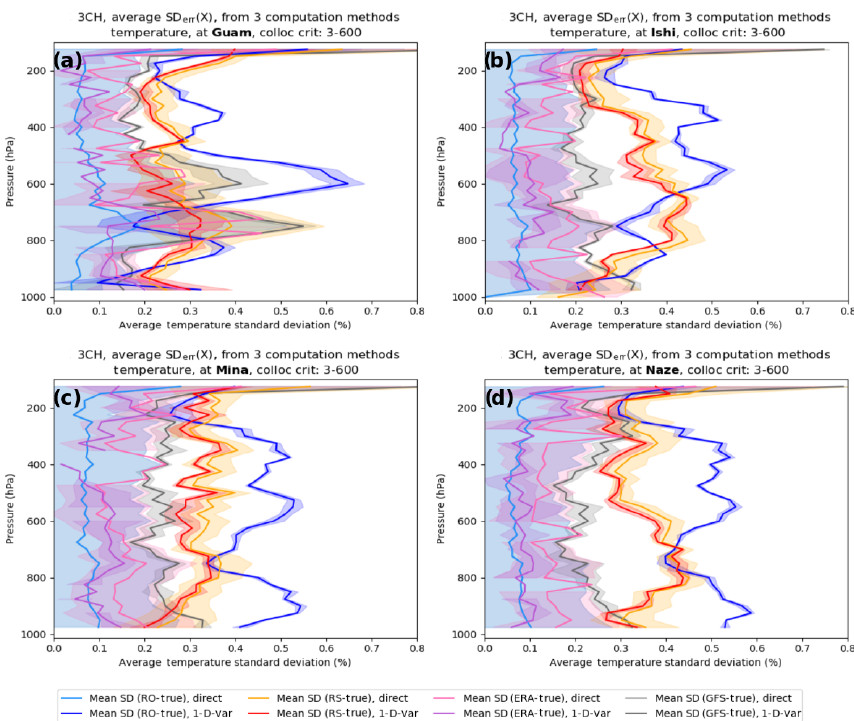
Figure B3. Mean and standard deviations (shading) of the three estimates of normalized temperature using RO-direct and RO 1D-VAR at (a) Guam, (b) Ishi, (c) Mina, and (d)